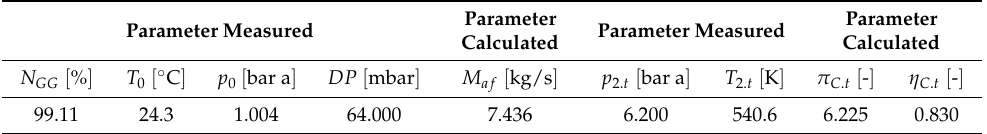
Table 6. Measured and calculated parameters at maximum working regime on the test bench, part one.